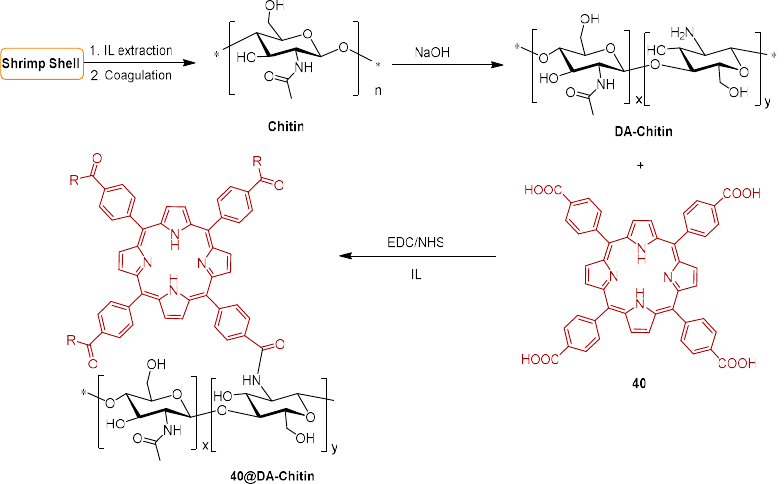
Figure 30. Strategy used by Rodgers to immobilize 5,10,15,20-tetrakis(4-carboxyphenyl)porphyrin ( 40 ) on chitin support, using ionic liquids (Ils) as solvents for both, chitin extraction and deacetylation (adapted form Ref. [187]).